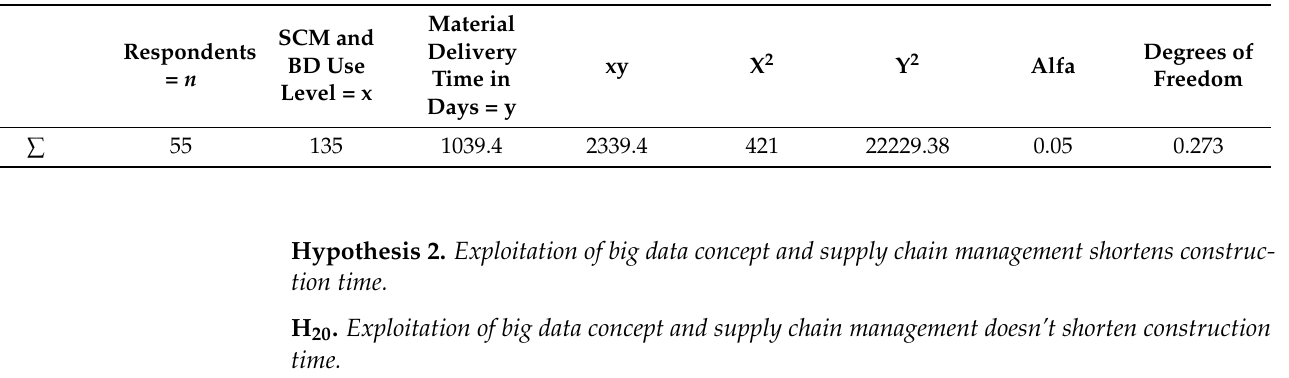
Figure 5. (a) Correlation between the examined variables (level of SCM and BD usage and construction time level) and (b) linear correlation between variables The relationship between the investigated variables is shown in the following graphs. A strong negative correlation is shown in almost all respondents. From these figures, it can see not only the trend but also a strong negative correlation. In cases where the level of use of BD and SCM was high, shorter times for the construction of sustainable buildings were also recorded. This negative correlation can also be seen in the table, reaching a value of − 0.778753 (Table 4 and 5). Table 4. Pearson correlation (SCM and BD use level and constriction time level). SCM and BD Use Level = x Construction Time = y SCM and BD use level = x